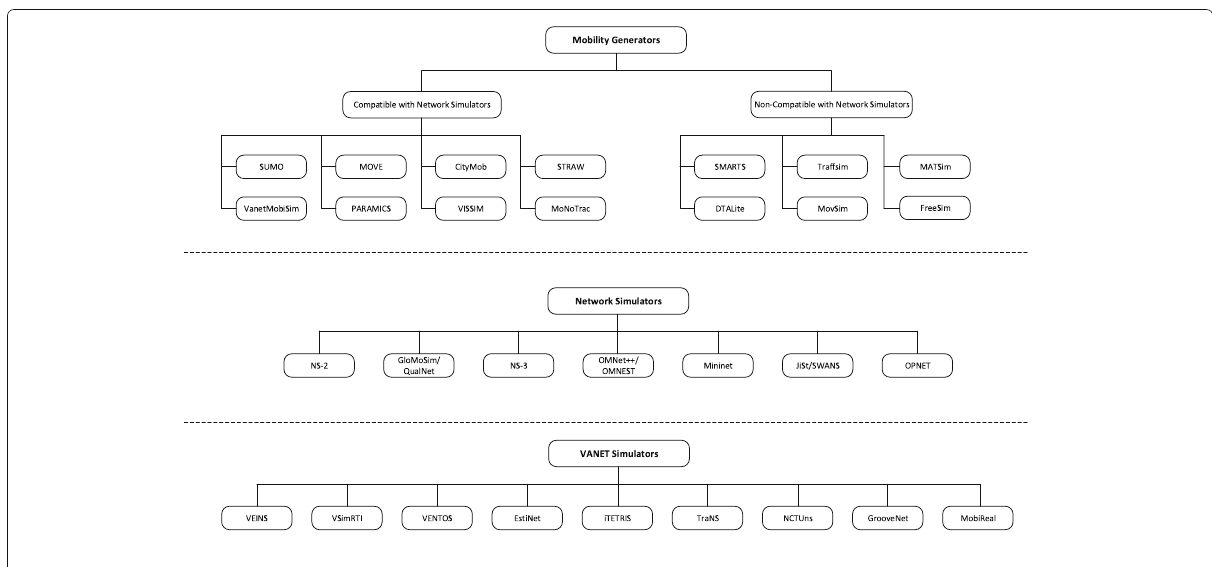
Fig. 7 Taxonomy of mobility generators, network, and VANET simulators’ list of all mobility generators, network simulators, and VANET simulation tools discussed in this